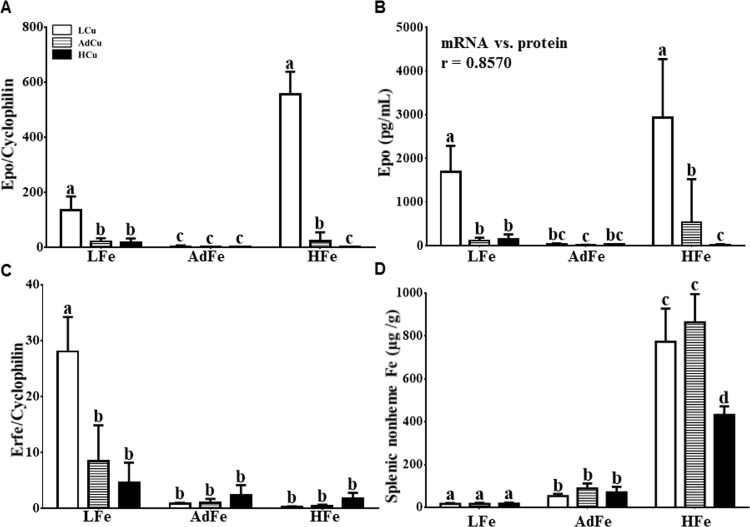
Renal Epo and splenic Erfe levels increased in rats consuming the LFe/LCu diet.Renal Epo mRNA (A) and serum Epo protein levels (B) were assessed in experimental rats. The Pearson product-moment correlation coefficient (r) comparing these 2 parameters is noted in the inset of panel B (p<0.0001). Splenic Erfe mRNA expression was quantified by qRT-PCR (C) and splenic nonheme iron levels (D) were measured using a commonly used technique. Labeled means without a common letter differ (p<0.05). Values are means ± SDs. n values and abbreviations used are the same as in Fig 1. Data for Epo mRNA and protein expression and splenic nonheme iron concentration were log10 transformed prior to running statistical analyses due to large variations in values. For ease of interpretation, we have, however, presented the non-transformed data in the figure. 2-way ANOVA factor analysis results are as follows: renal Epo mRNA (Fe: p<0.0001; Cu: p<0.0001; Fe X Cu: p<0.0001); serum Epo protein (Fe: p<0.0001; Cu: p<0.0001; Fe X Cu: p<0.0001); splenic Erfe (Fe: p<0.0001; Cu: p<0.001; Fe X Cu: p<0.0001); and splenic nonheme iron (Fe: p<0.0001; Cu: p<0.01; Fe X Cu: p<0.01).